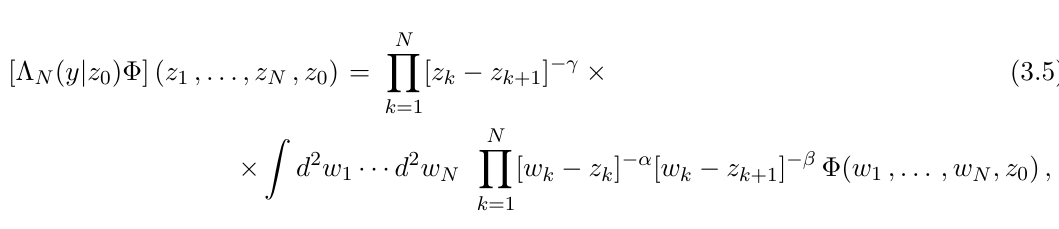
Figure 4 . The diagrammatic representation for the kernel of (cid:3) N ( y from z to w stands for [ w z ] (cid:0) (cid:11) . The indices are given by the following expressions: (cid:11) = 1 (cid:0) (cid:12) = 1 s + y , (cid:13) = 2 s (cid:0) (cid:0)